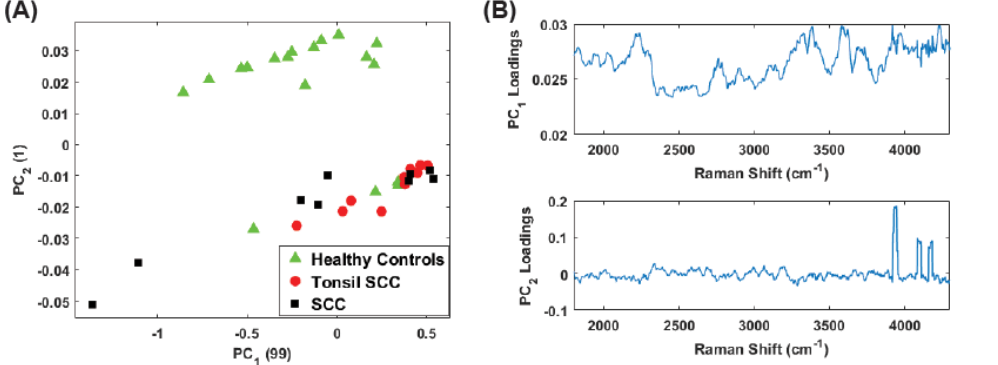
Figure 10. ( A ) Plot of the first two PC scores for the unstained tissue samples. The analysis was performed in the Raman shift region from 400 cm − 1 –4300 cm − 1 and show good separation between the healthy and diseased tissue classes. The numbers in parentheses represent the information content associated with each principal component. ( B ) Corresponding loadings plots for the PCs shown in ( A